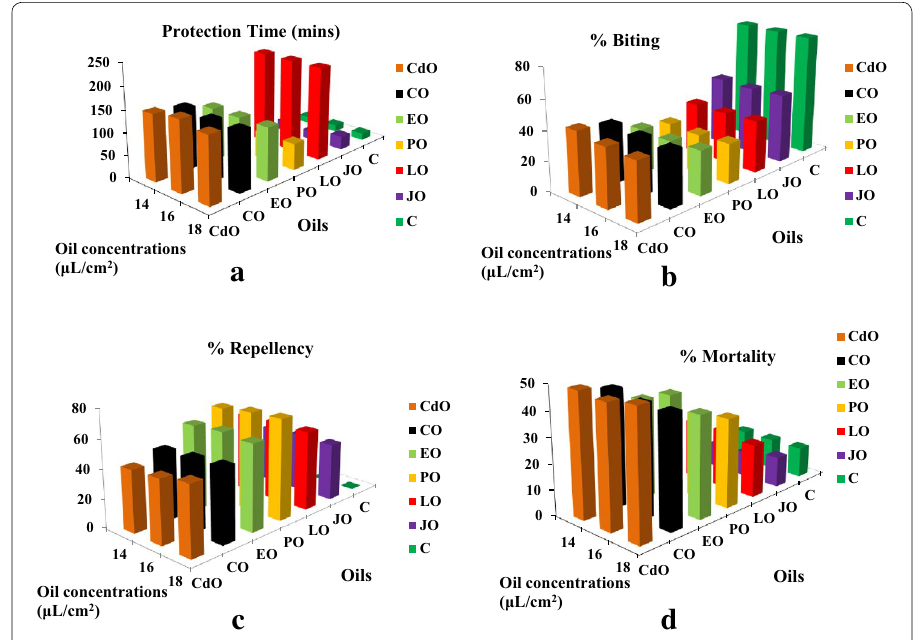
Fig. 10 a – d Bio assay of mosquito repellence of cotton treated with ICs of β-CD